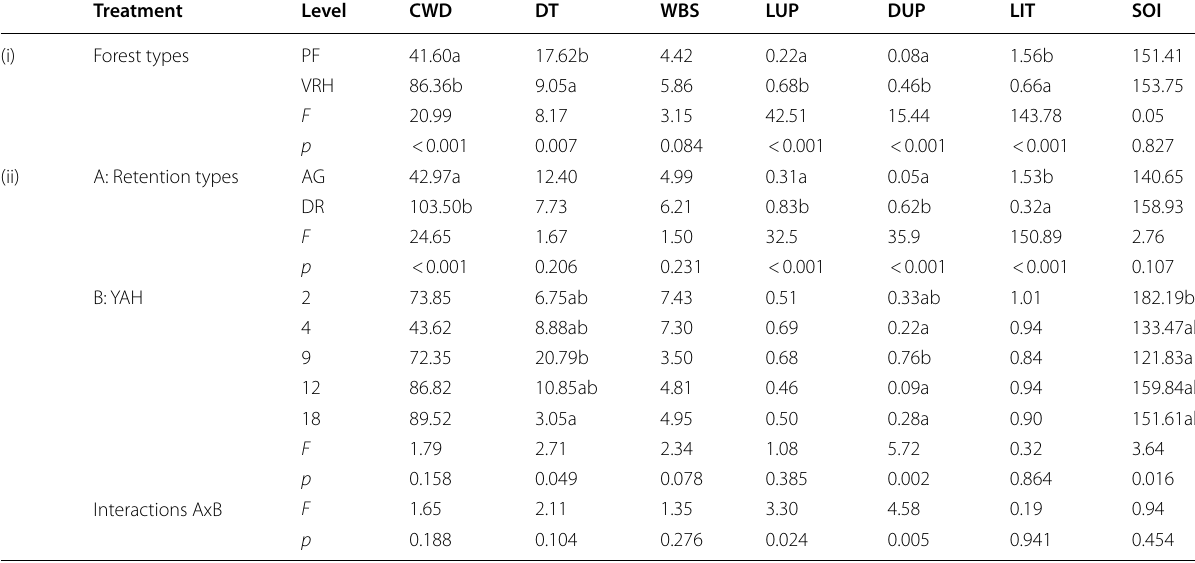
Table 5 Comparisons for carbon content (t C ha − 1 ) of the components of the deadwood, understory and soil layer categories (see Table 1): (i) simple ANOVAs considering primary unmanaged forests (PF) and stands under variable retention harvesting (VRH), and (ii) multiple ANOVAs considering different retention types in harvested stands (AG: aggregated retention; DR: dispersed retention) and years after harvesting (YAH) as main